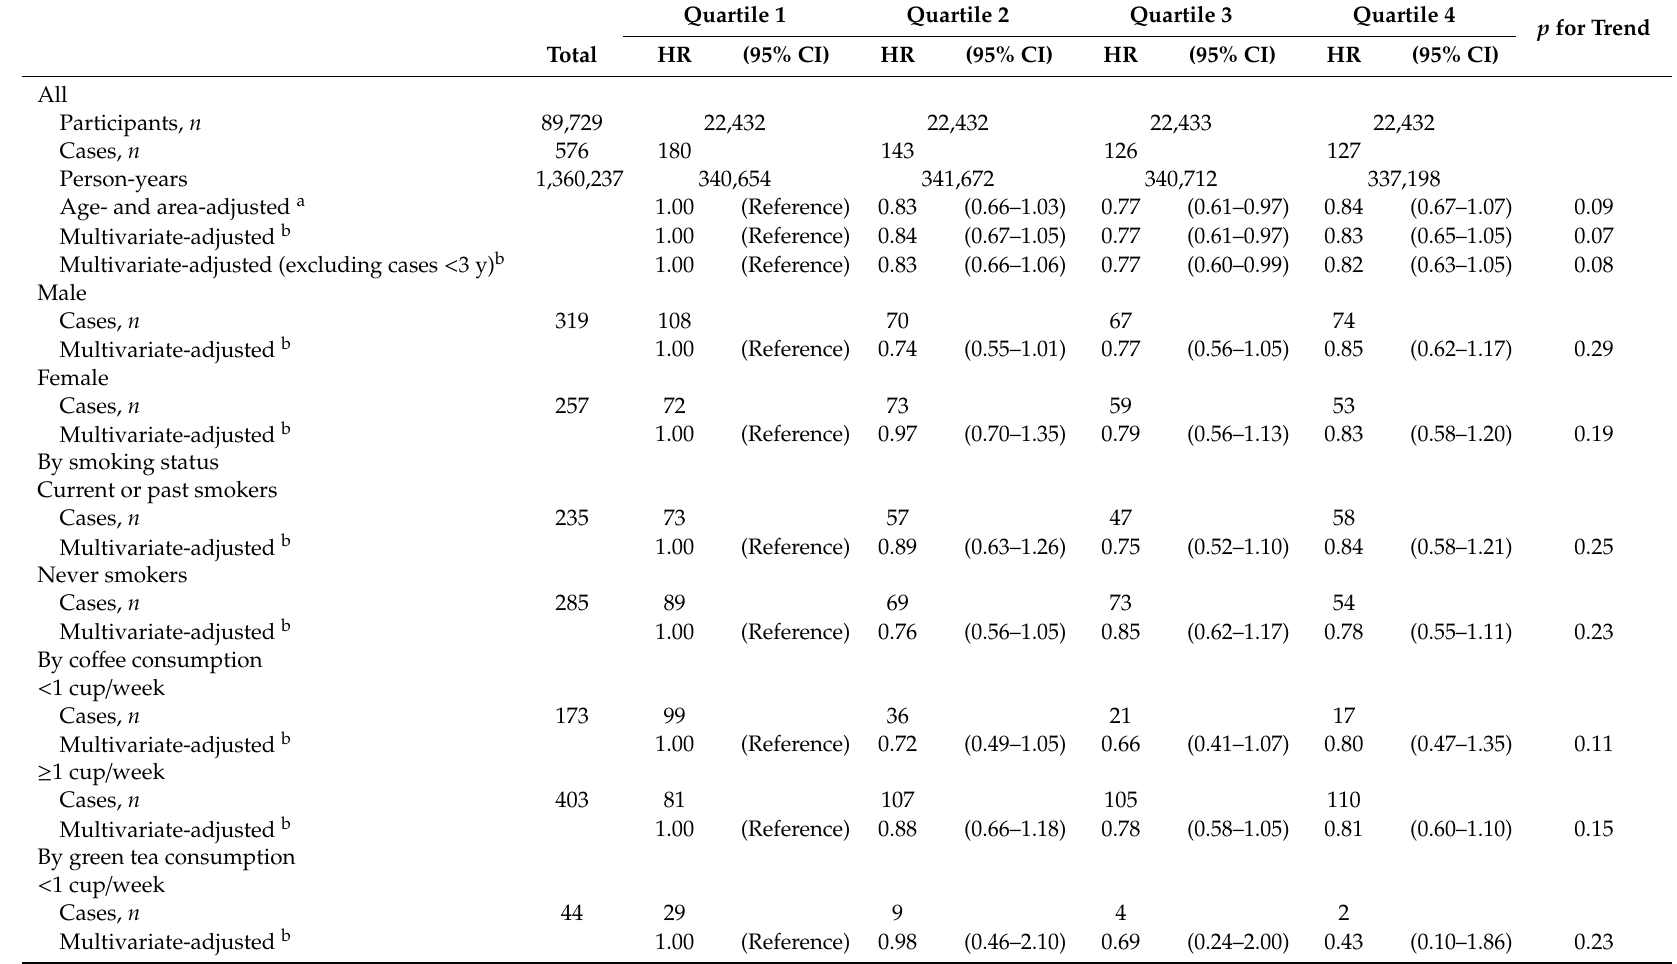
Table 2. Hazard ratios and 95% confidence intervals for pancreatic cancer risk according to quartile of acrylamide